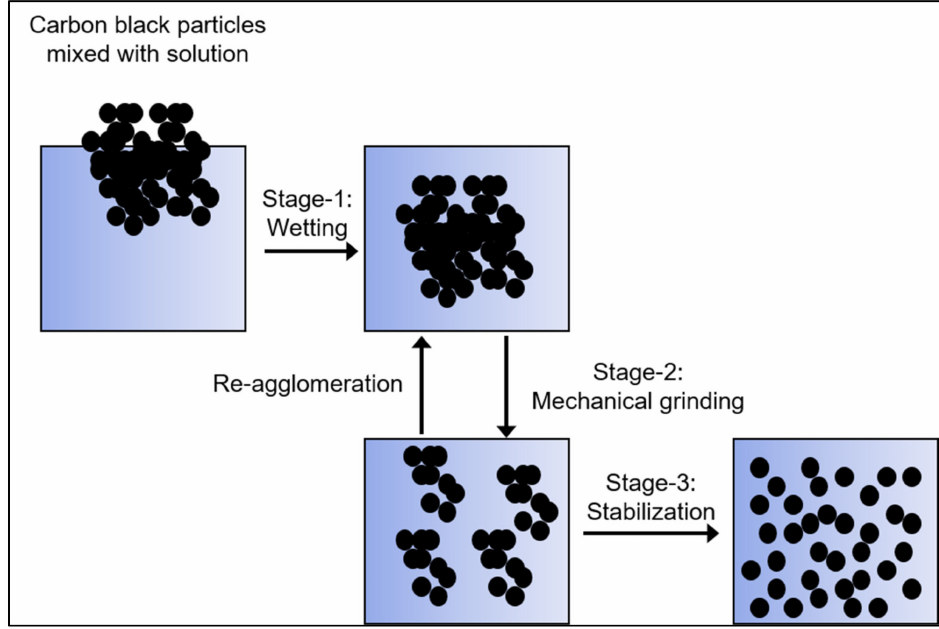
Figure 1. Three stages of CB particle-dispersing.